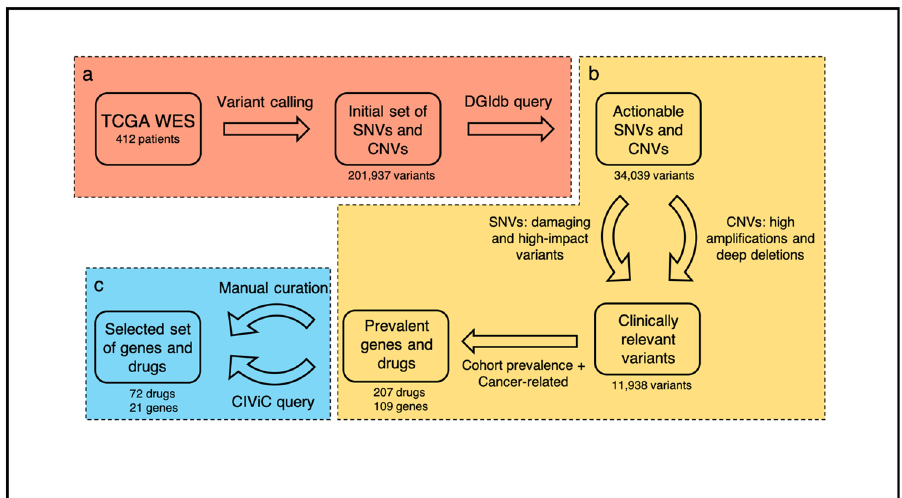
Figure 1. Workflow design—the diagram depicts the key steps of our in silico drug prediction. ( a ) After variant calling of whole-exome sequencing (WES) data from the TCGA bladder cancer cohort, a query was performed on the “Drug Gene Interaction database” (DGIdb) to identify targetable genomic alterations amongst the discovered mutations. ( b ) During the subsequent fully automated filtering phase, further selection criteria were applied. ( c ) In the semi-automated filtering phase manual curation complemented the automated query of the expert curated CIViC (“Clinical Interpretation of Variants in Cancer”) database, resulting in the final set of genes and drugs. (Microsoft PowerPoint; version